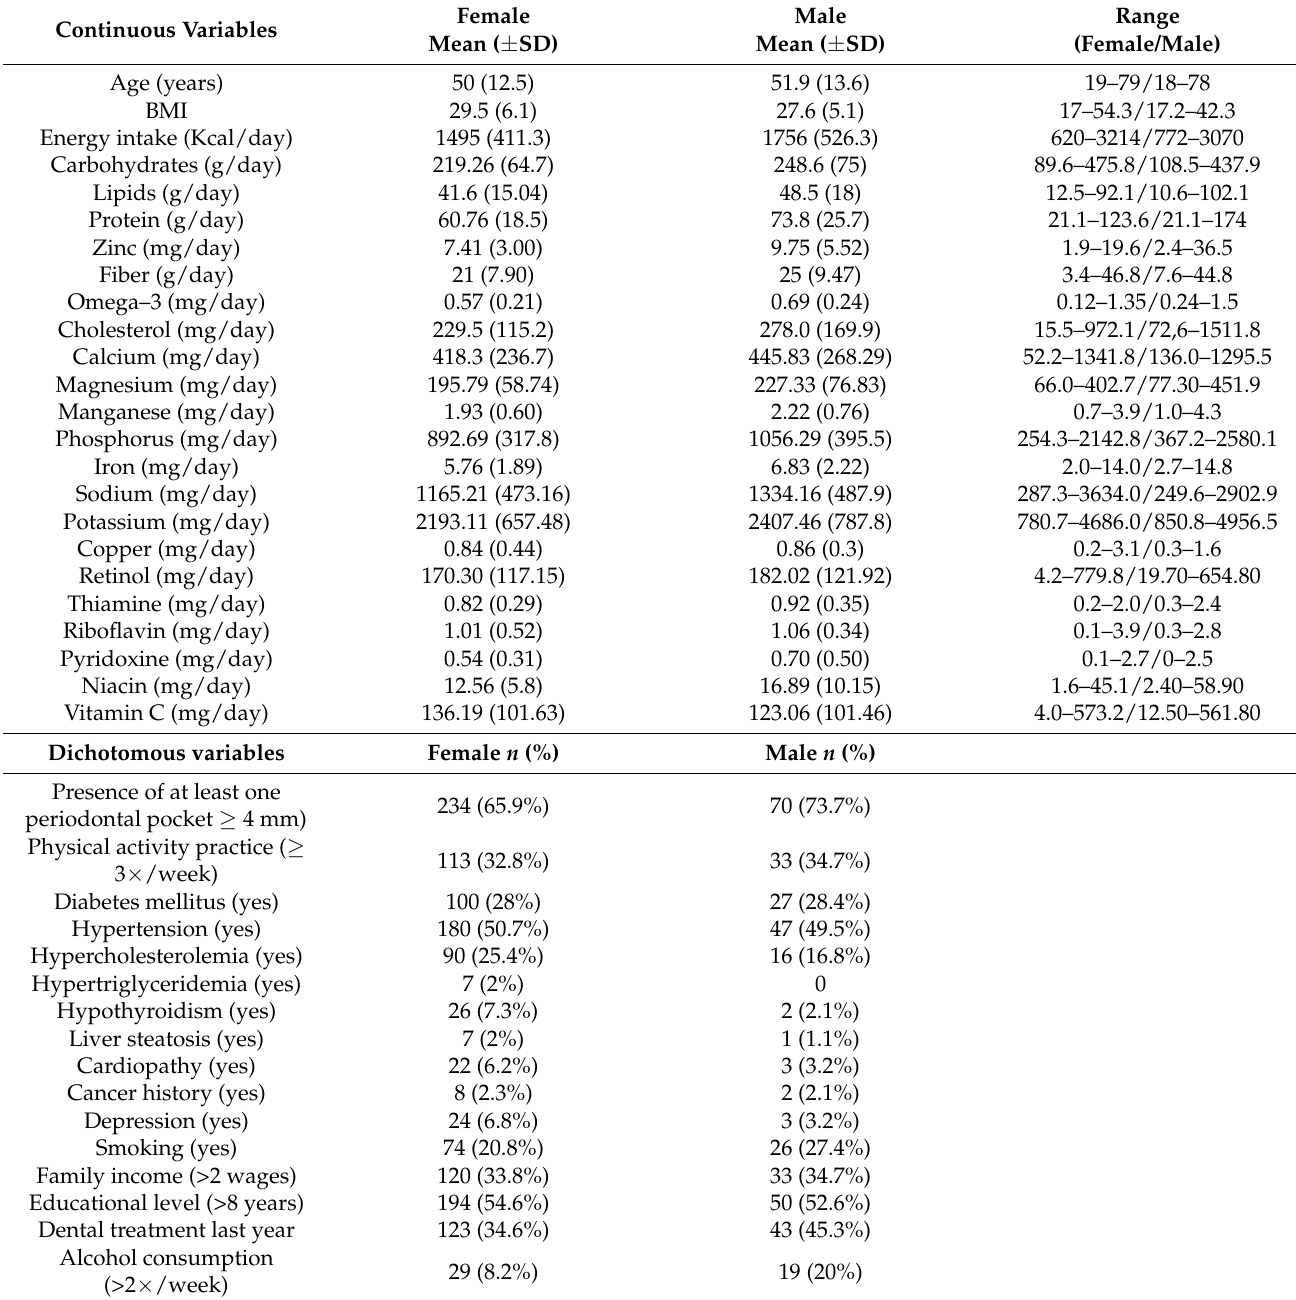
Table 1. Sample distribution in accordance with socio-demographic and nutritional profile ( n =